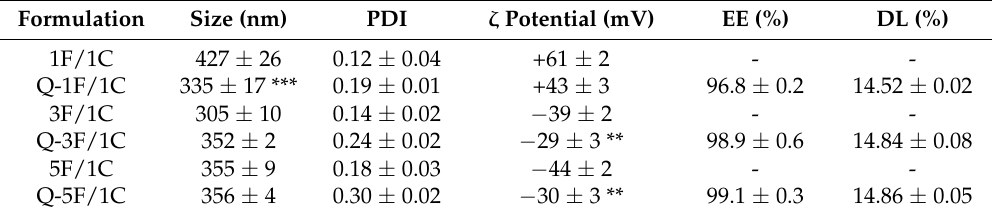
Table 2. Physicochemical characterization of fucoidan/chitosan nanoparticles. Formulation